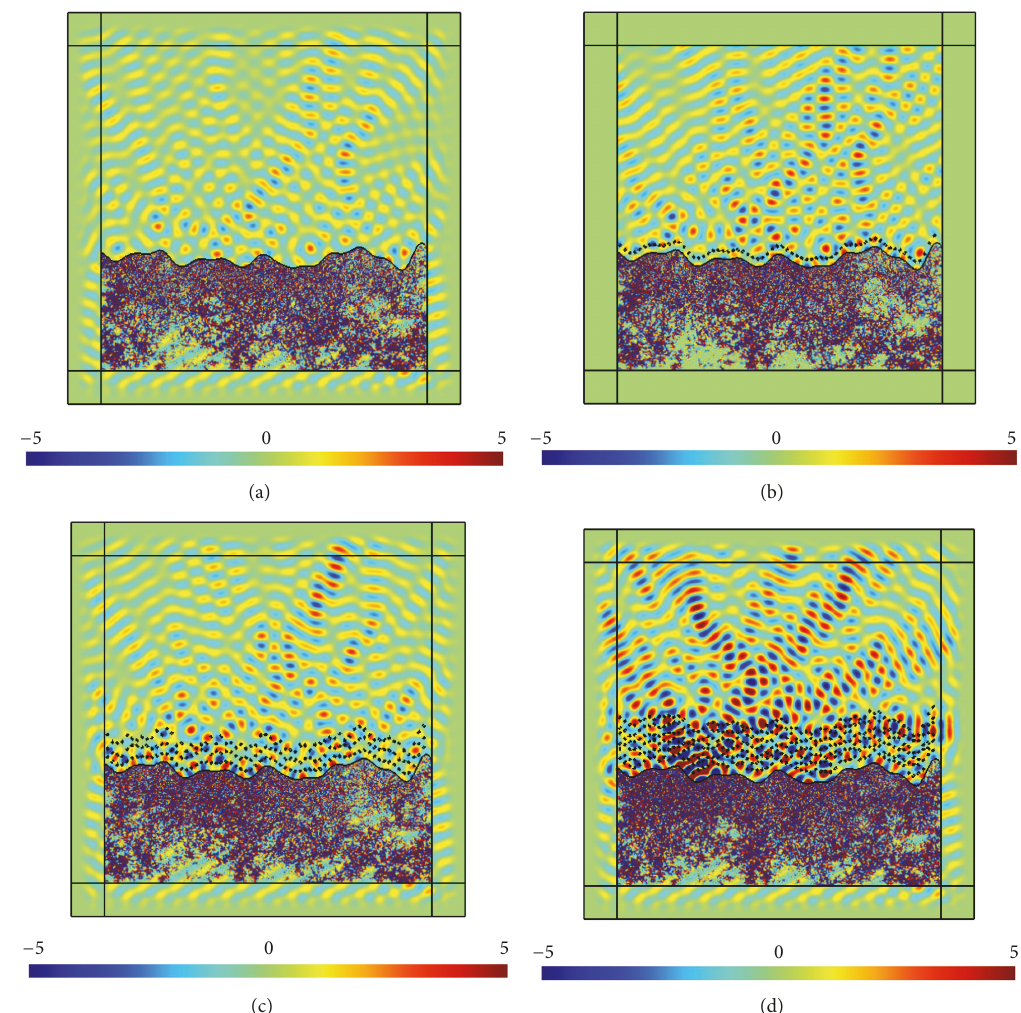
Figure 5: Near scattering field of ground surface with different layers of vegetation. (a) Scattering field without vegetation, (b) scattering field with 1 layer of vegetation, (c) scattering field with 3 layers of vegetation, and (d) scattering field with 6 layers of